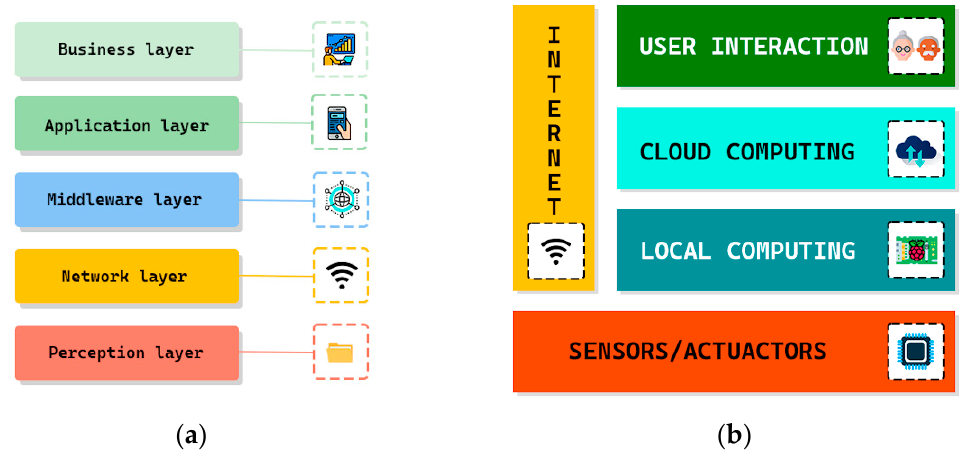
Figure 6. Support architectures of MFPTG4IoTDs for IoTS development. ( a ) Vashi et al.’s architec- ture [196]. ( b ) Guerrero-Ulloa et al.’s architecture, adapted with permission from Ref. [22]. 2022, Gleiston Guerrero-Ulloa, Carlos Rodríguez-Domínguez, Miguel J. Hornos.